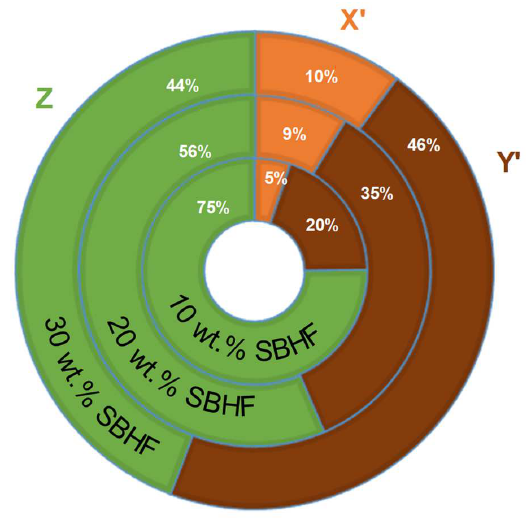
Figure 6. Proportional contributions of the matrix (Z), subcritical fibers (X’), and supercritical fibers (Y’) to the tensile strength of each PLA/SBHF composite material. (Y’) to the tensile strength of each PLA/SBHF composite